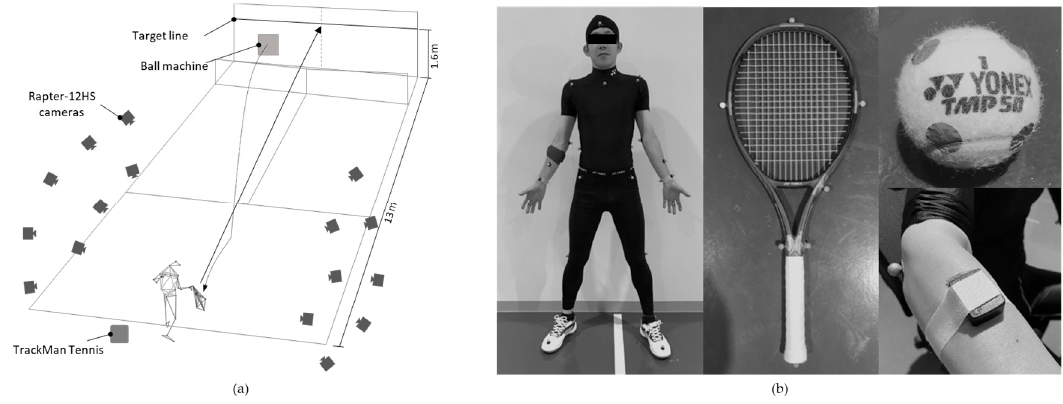
Figure 1. ( a ) The experimental set-up; ( b ) Placement of the reflective markers in the body, the racquet and the ball. Two pairs of surface electromyography (EMG) were placed at the extensor carpi radialis muscle and flexor carpi radialis